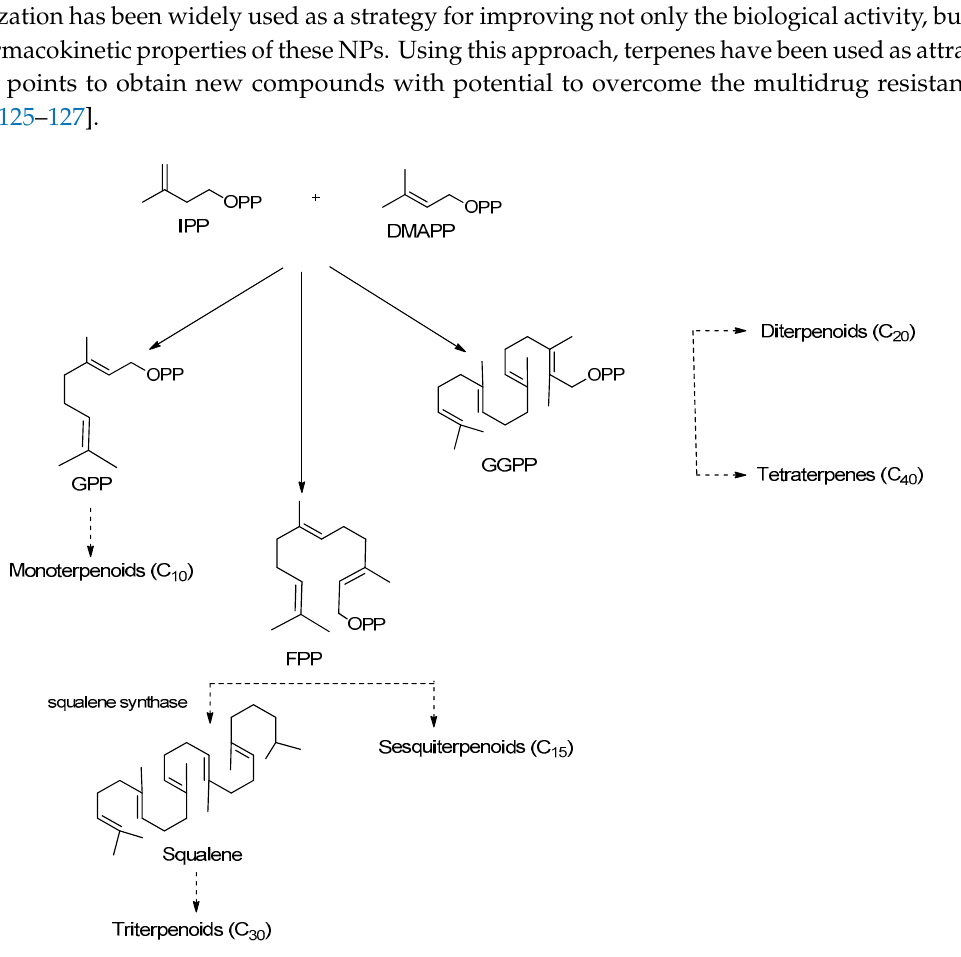
Figure 13. Simplified biosynthetic pathways of terpenes [123].